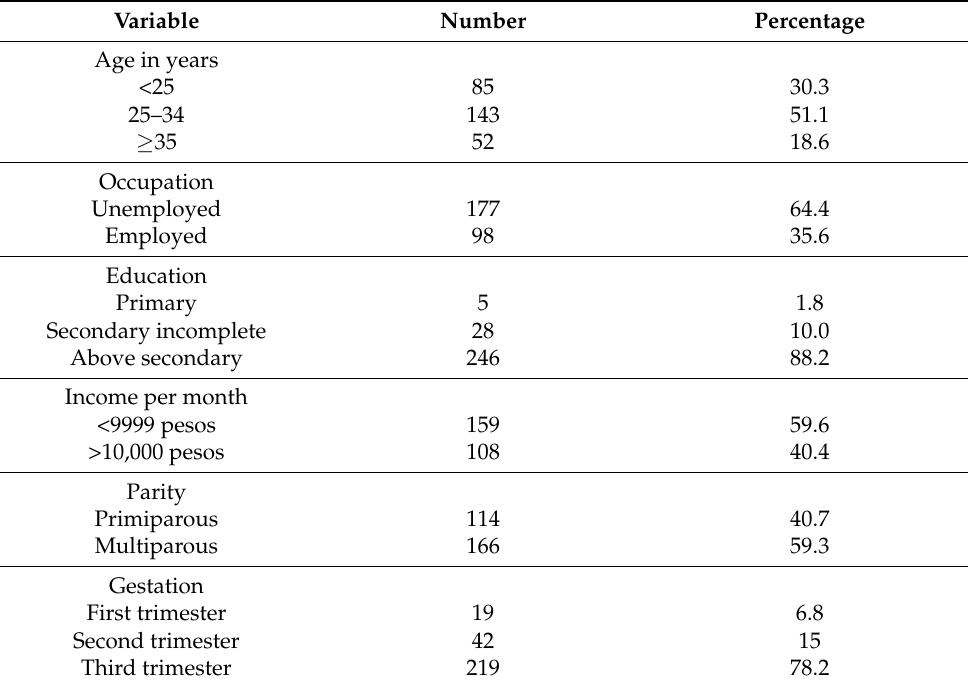
Table 1. Sociodemographic characteristics of the study participants ( n =